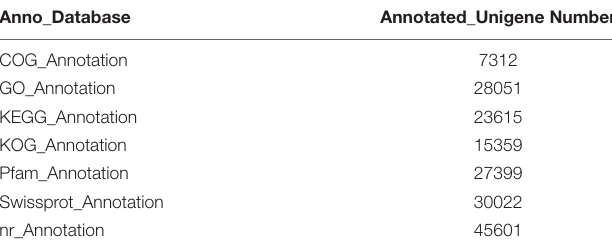
TABLE 5 | Gene annotation in different